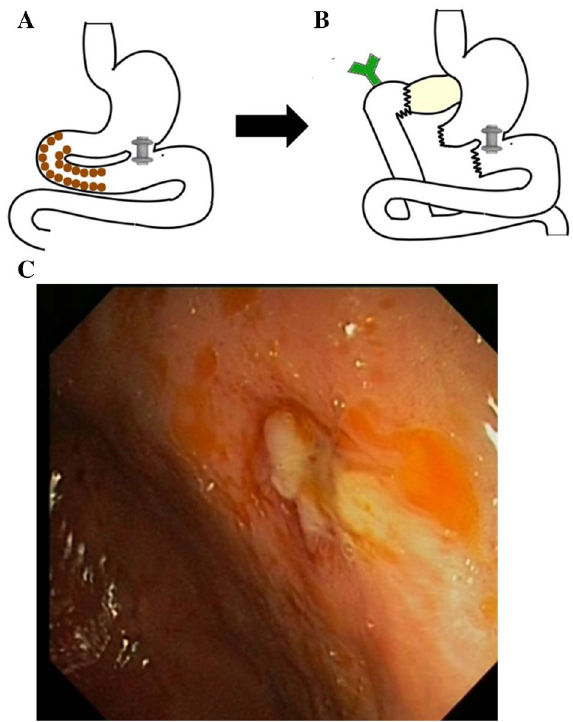
Figure 3. Graphic scheme of the patient’s anatomy before ( A , left) and after Whipple procedure ( B , right). Brown dots correspond to tumor. ( C ) Gastrojejunal anastomosis 26 days after removal of the